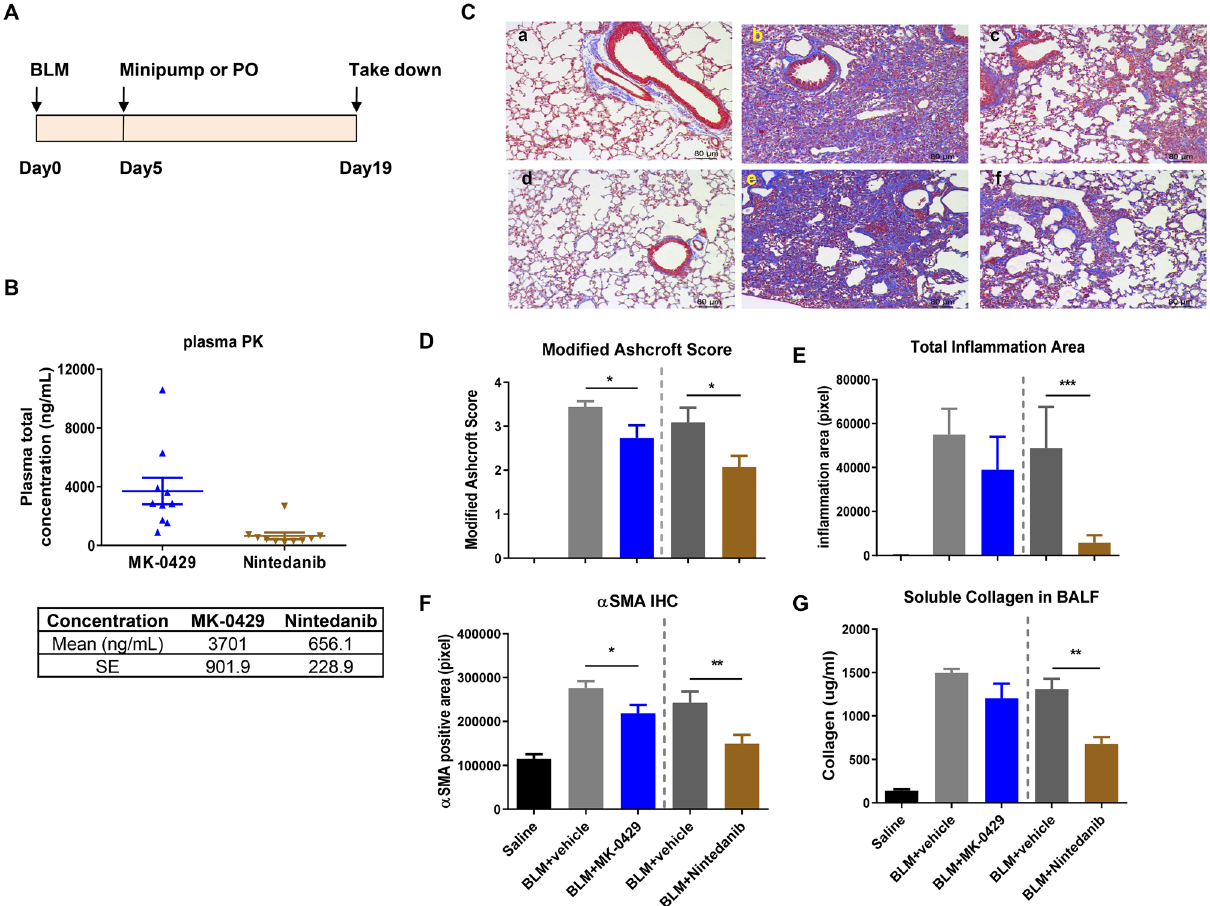
Figure 2. MK-0429 inhibits lung fibrosis in the bleomycin mouse model. ( A ) Schematics of compound administration in BLM model. 5 days after BLM intra-tracheal instillation, the animals were given MK-0429 (200 mpk via osmotic minipump for 2 weeks) or Nintedanib (60 mpk po qd for 2 weeks). Lungs were collected at Day 19 for histological and biochemical evaluation. mpk, milligrams per kilogram body weight; po, Per os , oral administration; qd, Quaque die , every day. ( B ) Plasma total drug concentration was measured 2 h after final oral dose at Day 19. ( C ) Representative Masson Trichrome staining of mouse lungs. a and d, saline intra-tracheal instillation; b-f, BLM intra-tracheal instillation; a and d, no compound treatment; b, vehicle in minipump; c, MK-0429 in minipump; e, vehicle po; f, Nintedanib po. D) Modified Ashcroft scores of mouse lung. Mean ± SEM, n = 10. One-way ANOVA followed by Tukey’s test, *p < 0.05, **p < 0.01, ***p < 0.005 vs BLM- vehicle group. ( E ) Total inflammation area in mouse lungs. Mean ± SEM, n = 10. One-way ANOVA